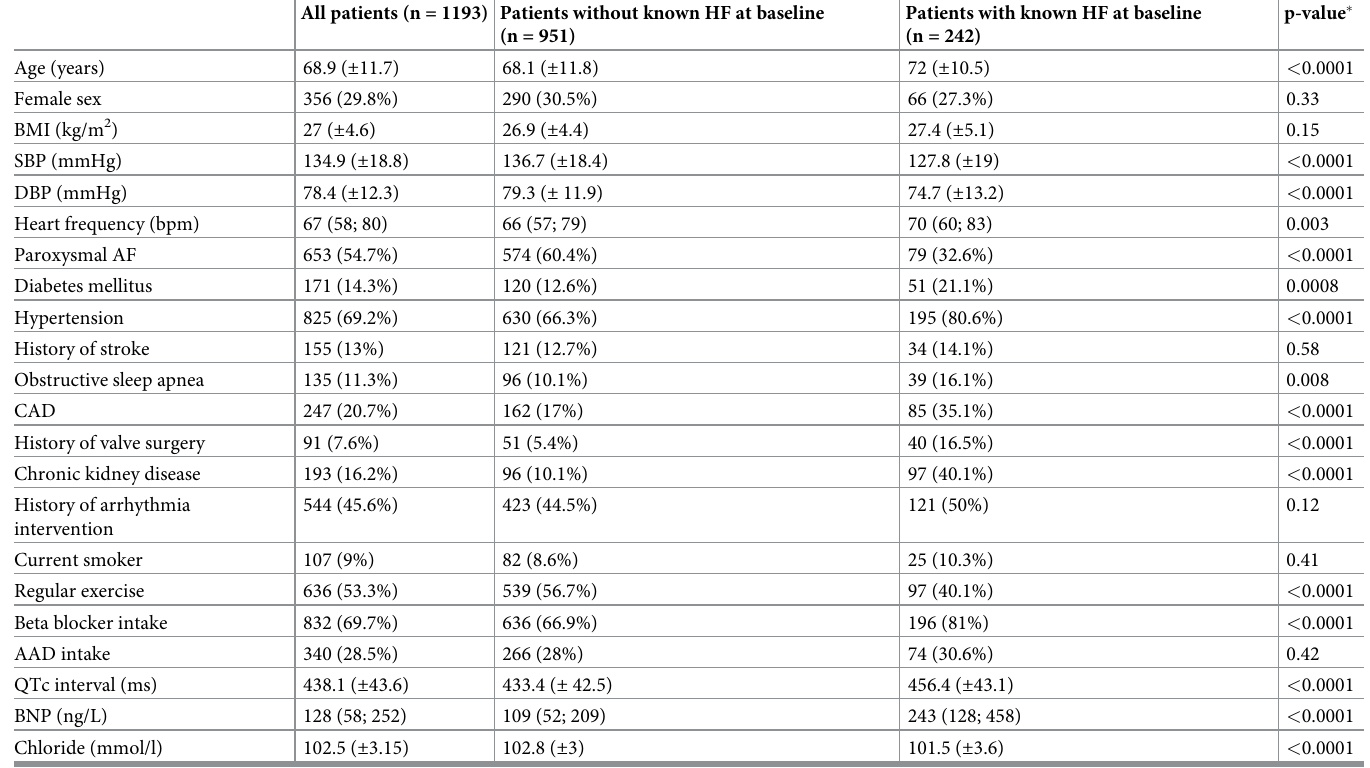
Table 1. Baseline characteristics.